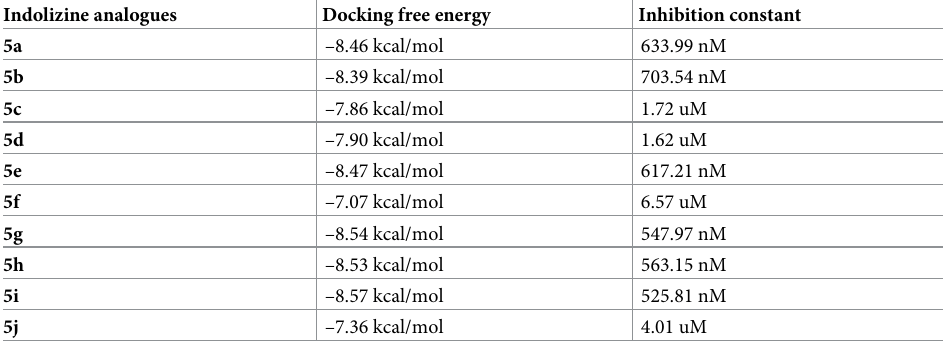
Table 5. Docking free energy and estimated inhibition constant (K i ) of the docked indolizine analogues